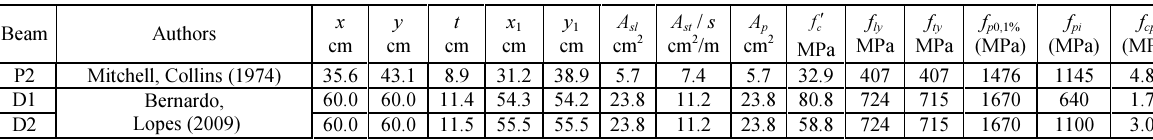
Table 7. Properties of experimental PC hollow beams Beam